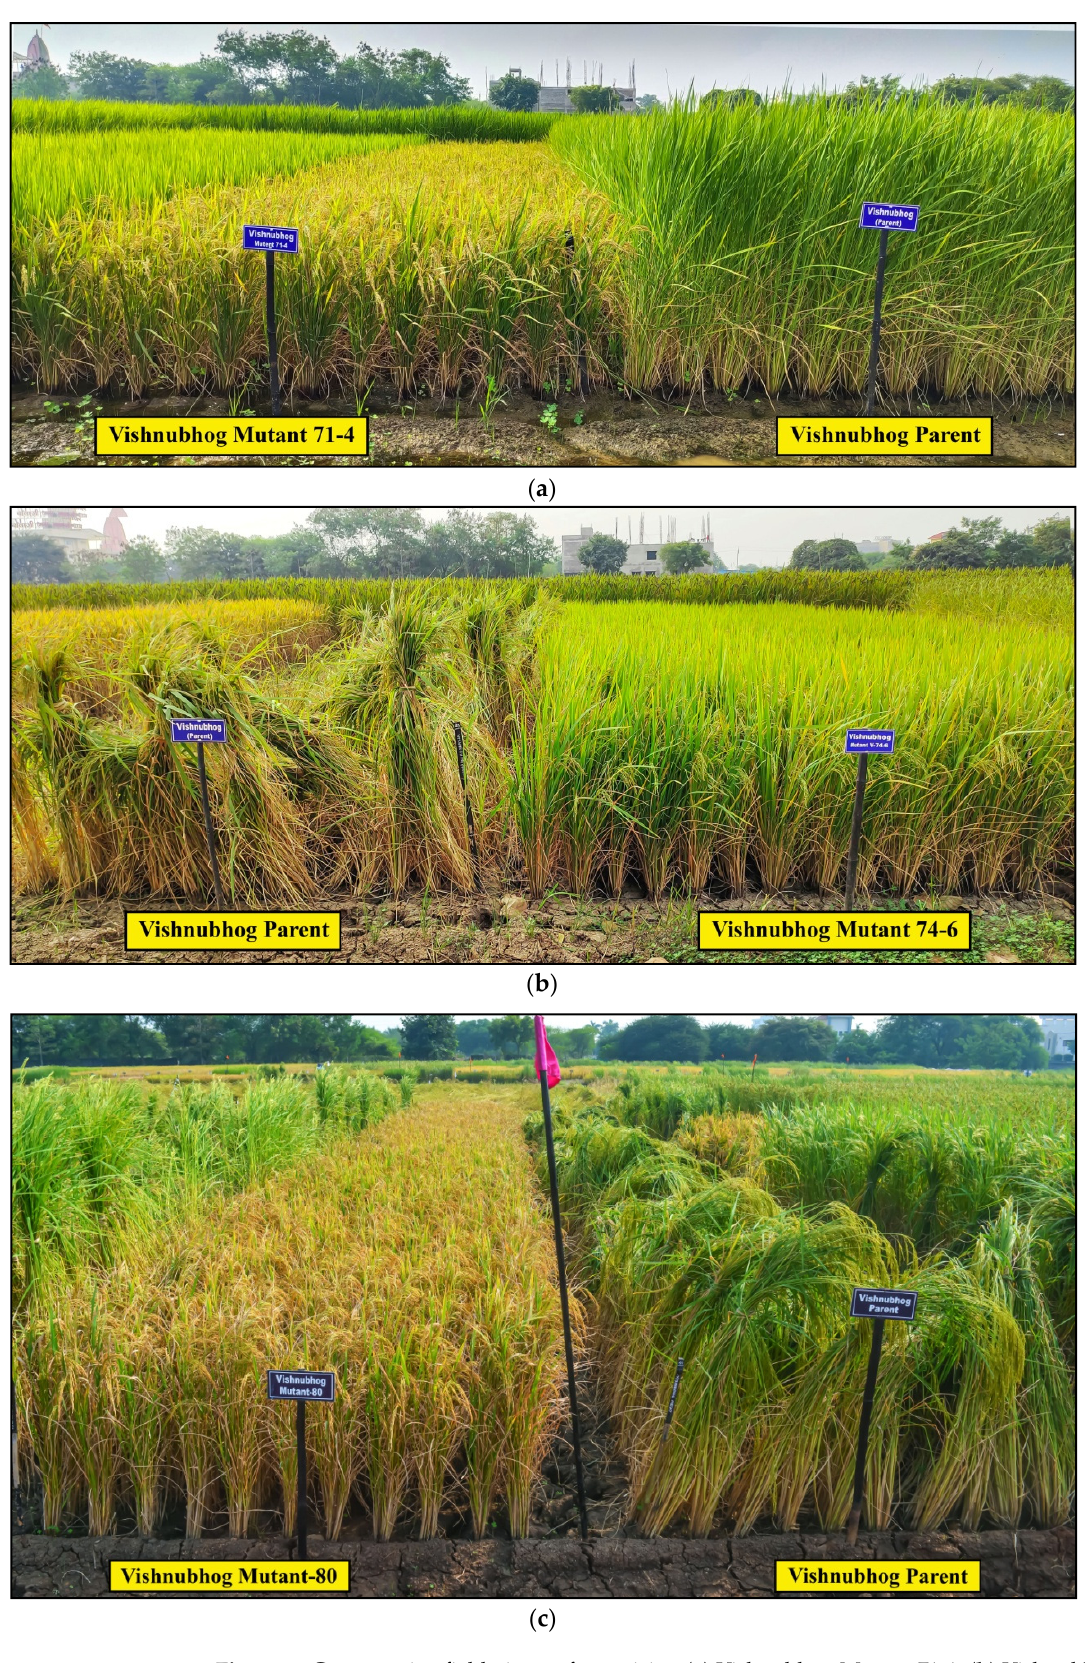
Figure 6. Comparative field views of promising ( a ) Vishnubhog Mutant 71-1, ( b ) Vishnubhog Mutant 74-6 and ( c ) Vishnubhog Mutant 80 with the Vishnubhog parent.